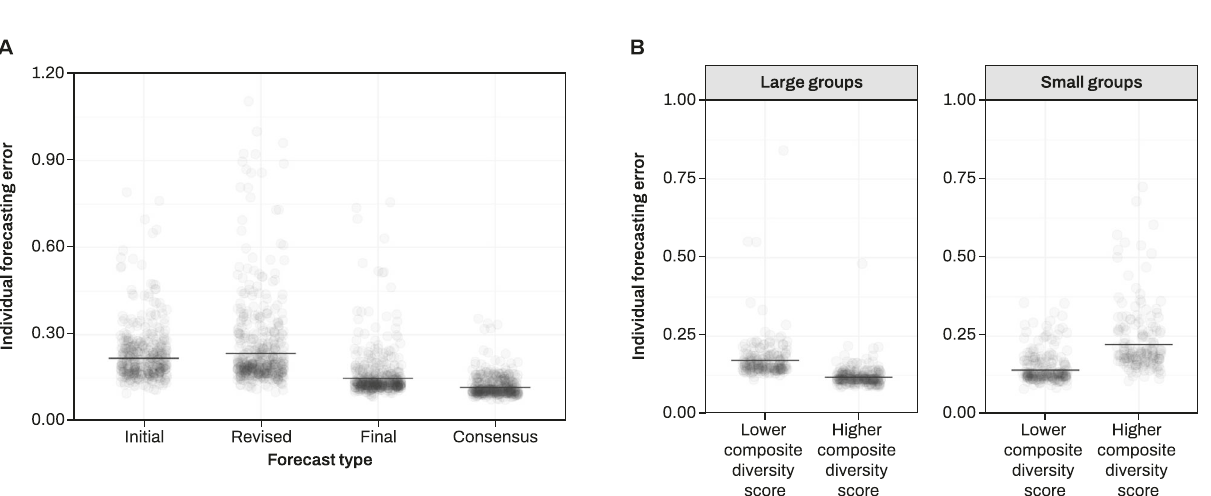
Table of analysis on forecasting errors (in Brier scores) for individual (A – B) and aggregated measures (C – D), and as a function of forecast type (A – C) and condition (B – D). Baselines for each factor: consensus, homogeneous, large/non-modular.The effectof fi nal forecasts onindividual errors(A) and the effects of composite diversity and the interaction between compositediversity and modularity (D) did not survive a Bonferroni correction. Boldface: p <0.05; italics: p <0.10. Tables B – C represent exploratory analyses. Hypotheses in tables A and D were preregistered. All analyses were also repeated with binarized accuracy (Supplementary Tables 11 – 14) and logit link function (Supplementary Table 15). For convenience, all tests refer to two-sided hypotheses and were calculated with the lmerTest package in R 63 .